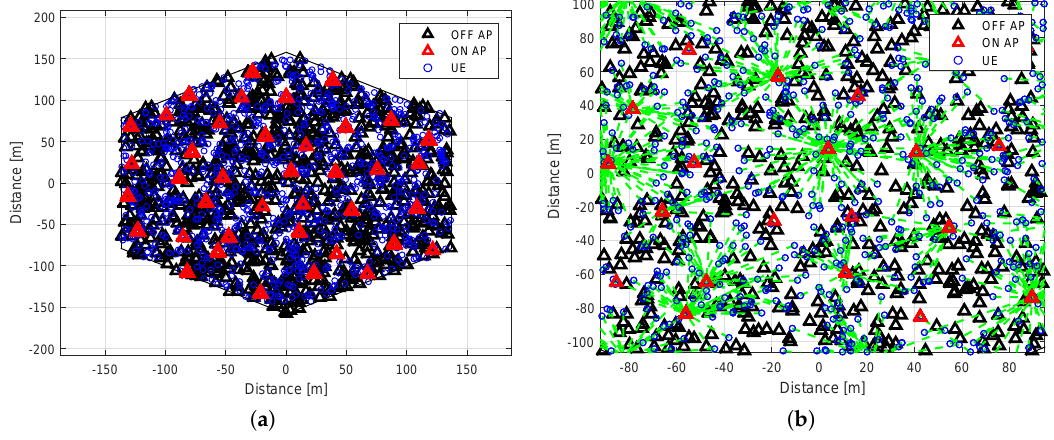
Figure 8. An example of the ON/OFF states of 1000 APs when the UE-N algorithm is used in the case of 1000 UEs. ( a ) Thirty nine APs turned on among 1000 APs; ( b ) user association between turned-ON APs and